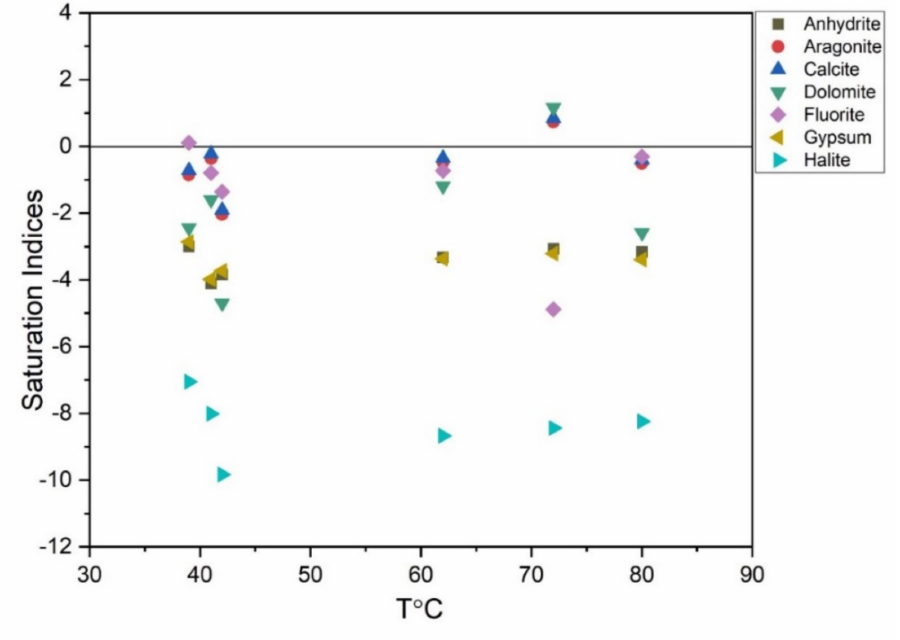
Figure 10. Graph showing the saturation state of different minerals of the Suichuan thermal waters. In (Figure 11), most of the thermal waters are dispersed near dolomite and calcite tie lines, showing the dissolution process of carbonate rocks [63], whereas thermal water located near the anhydrite corner indicates the dominance of evaporite minerals